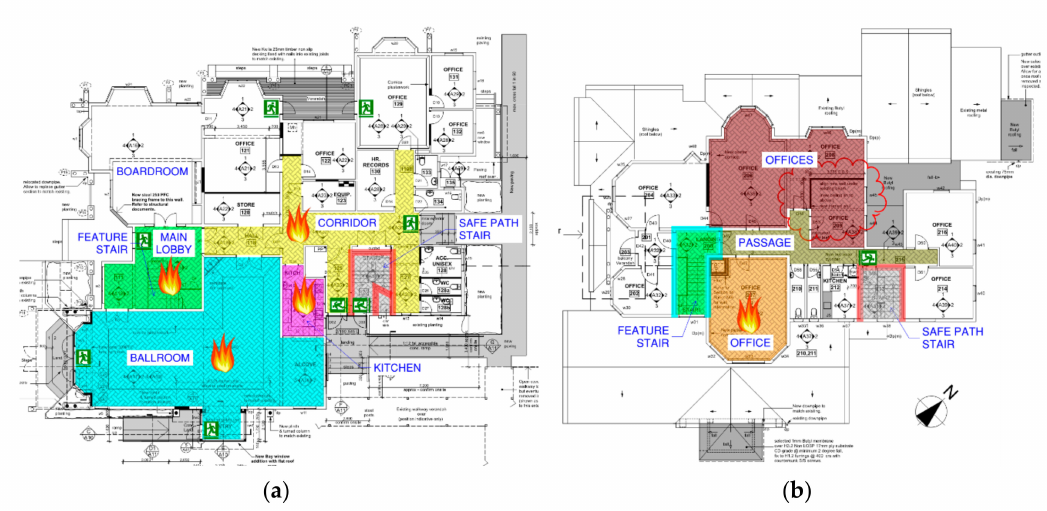
Figure 6. Design fires and modelled spaces of McDougall House: ( a ) Ground floor; ( b ) First